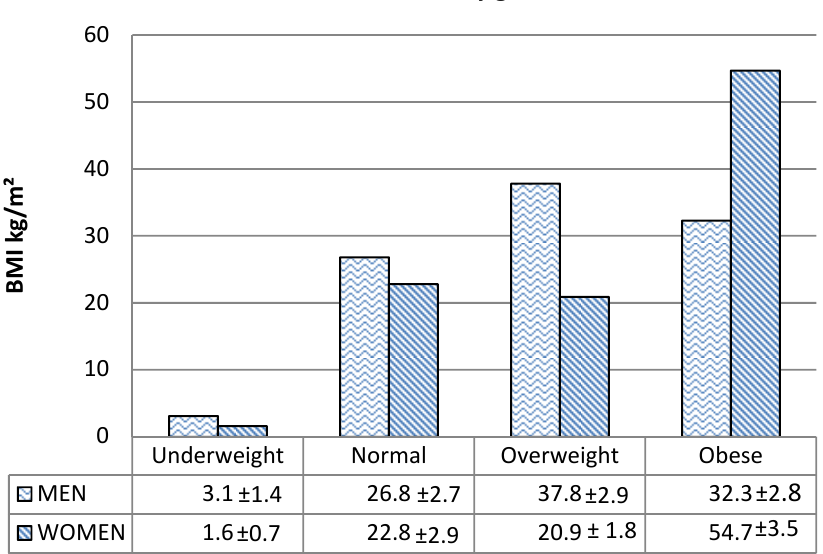
Rao Scott Chi-square = 28.95 df = 3 P value <